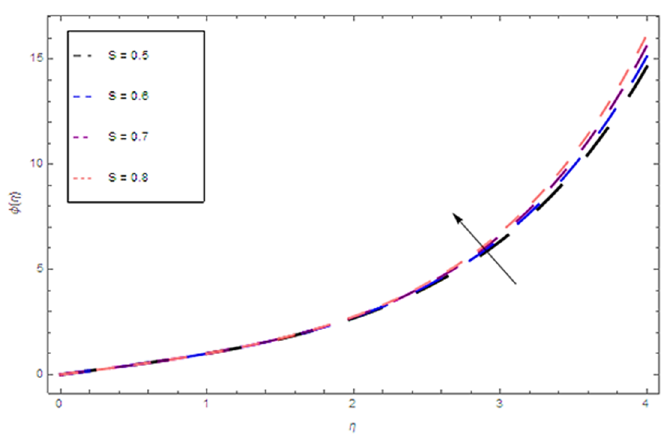
Figure 16. Impact of S over Figure 16. Impact of S over θ ( η ) , when M = 0.3, Nb = 0.6, Nt = 0.7,Pr = 2, Sc = 0.5, Ω = 1. Figure 16. Impact of S over